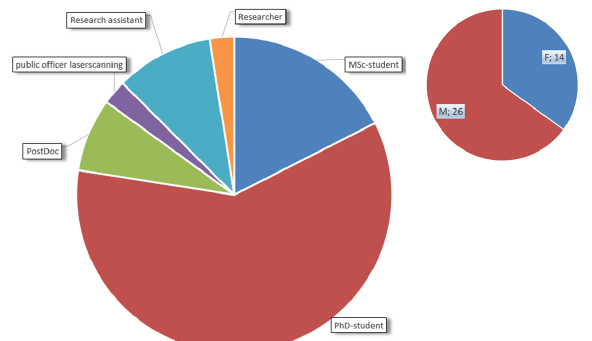
Figure 1. Breakdown of participants’ profile (left) and gender (right)